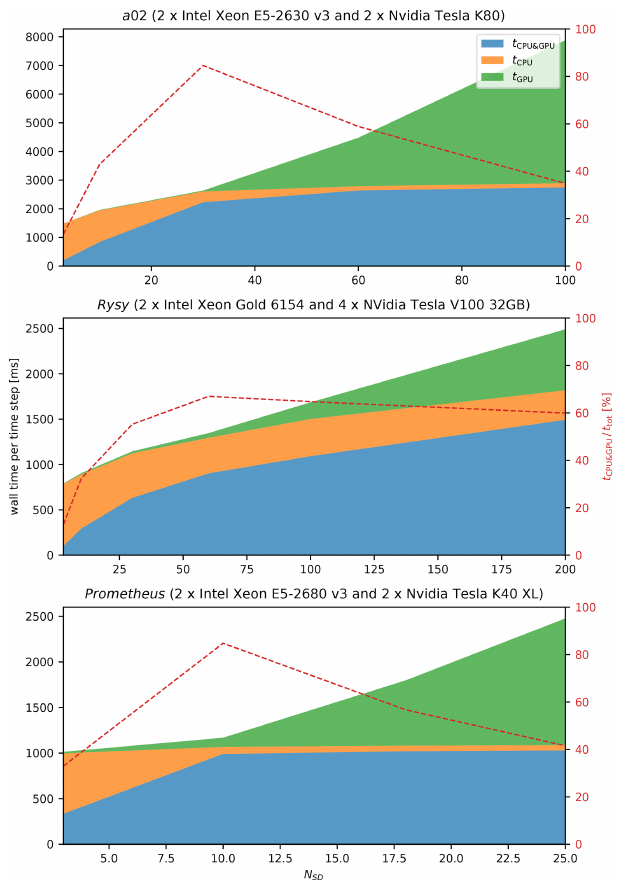
Figure 3. Single-node (no MPI) UWLCM-SDM performance for different hardware. The wall time per model time step averaged over 100 time steps. The results of LES of a rising thermal done on three different systems for a varying number of super-droplets, N SD . t CPU , t GPU and t CPU&GPU are wall times of CPU-only, GPU- only and parallel CPU and GPU computations, respectively. These timings are presented as stacked areas of different color. Total wall time per time step t tot is the upper boundary of the green area. The dashed red line is the percentage of time spent on parallel CPU and GPU computations.